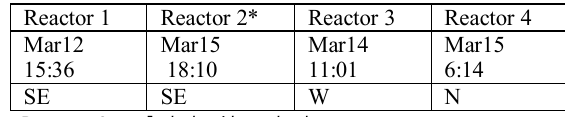
Table 2. Hydrogen explosions and wind directions